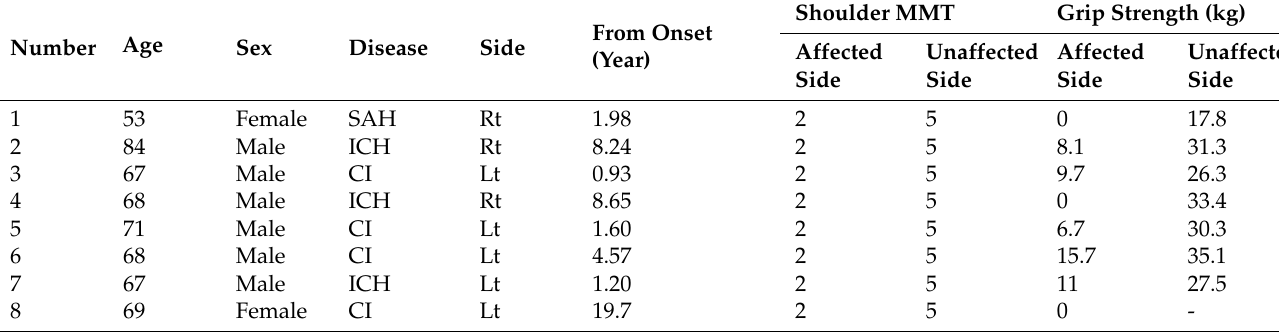
Table 1. Patient